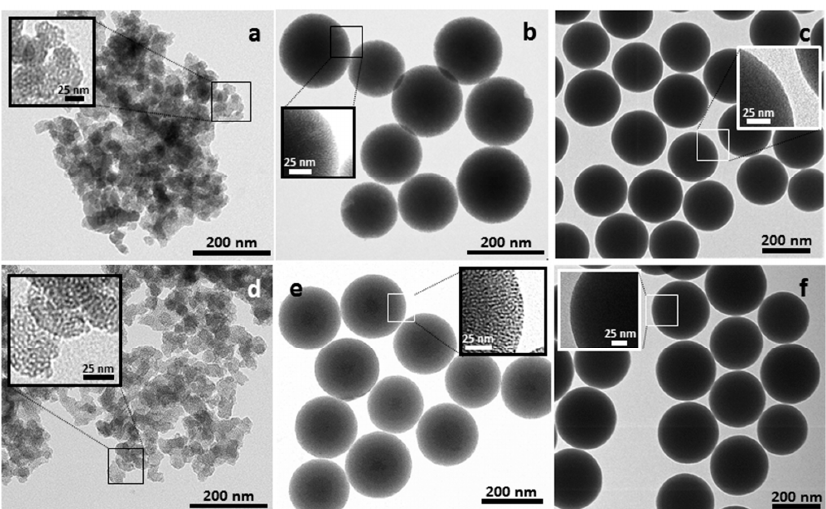
Figure 1. TEM images of the pure silica based materials ( a ) UVM-7, ( b ) mesoporous Stöber nanoparticles (MSNP) and ( c ) massive Stöber nanoparticles (SNP), and selected modified materials functionalized with chlorotrimethylsilane ( d ) U7-3C 1 , ( e ) MS-3C 1 and ( f ) SP-3C 1 . Images with higher magnification are shown in the insets showing the porous (U7, U7-3C 1 , MS and MS-3C 1 ) or massive (SP and SP-3C 1 ) nature of the materials.